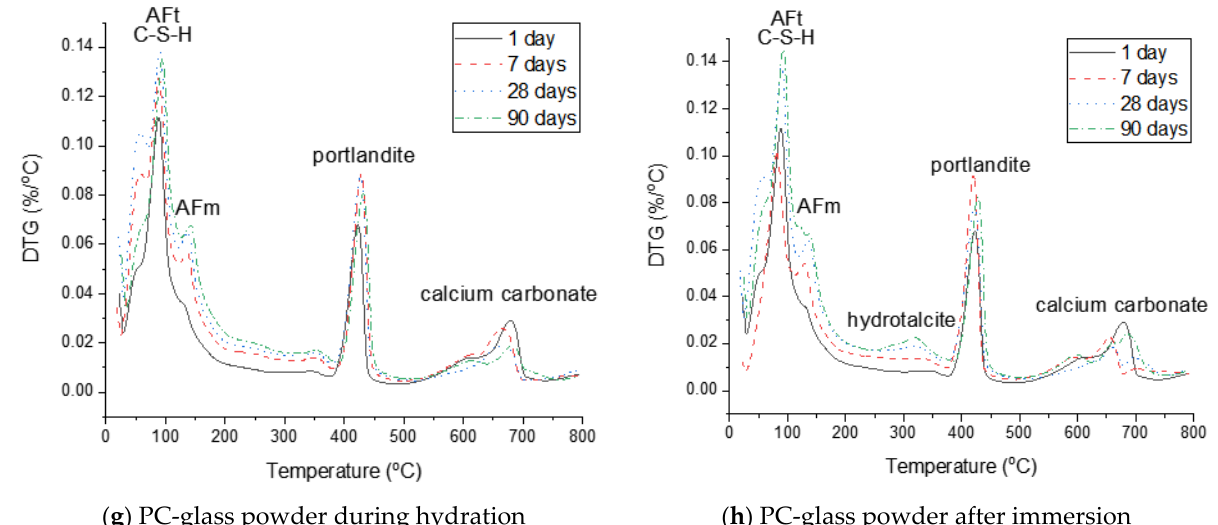
( g ) PC-glass powder during hydration ( h ) PC-glass powder after immersion Figure 9. Derivative thermogravimetric analysis (DTG) curves of neat PC and PC blended with silica fume, metakaolin or glass powder during hydration and after immersion in seawater up to 90 days.